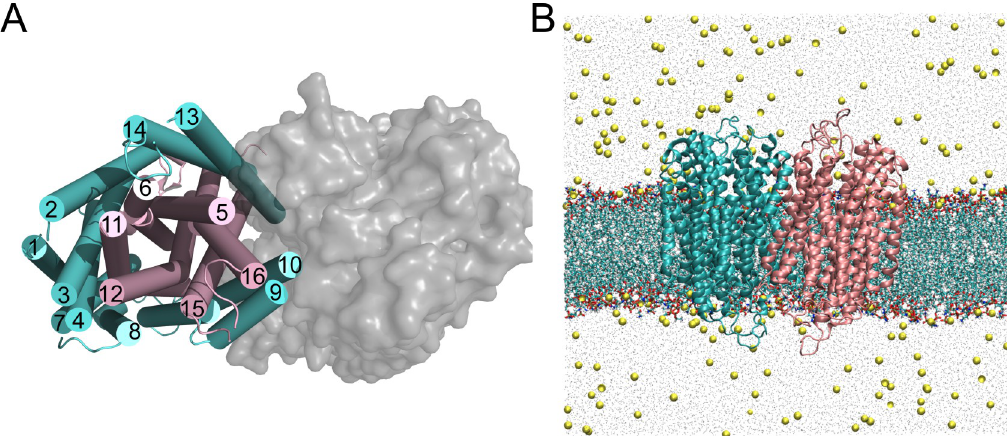
Fig 1. The structure of Tm -PPase and simulation box set up. A) the Tm -PPase resting state crystal structure (PDB: 4AV3) viewed from above to demonstrate the concentric circles of TMH of each subunit (outer ring in cyan and inner in pink) and the TMH contributing to the interface with the adjoining subunit (grey surface representation). B) The atomistic simulation box where the protein subunits are each coloured in cyan and pink and shown as Cartoon representation, the POPE (80%) and POPA (20%) bilayer is shown as lines representation and the water particles are grey points, and the ions (NaCl 150 mM) are shown as yellow VDW